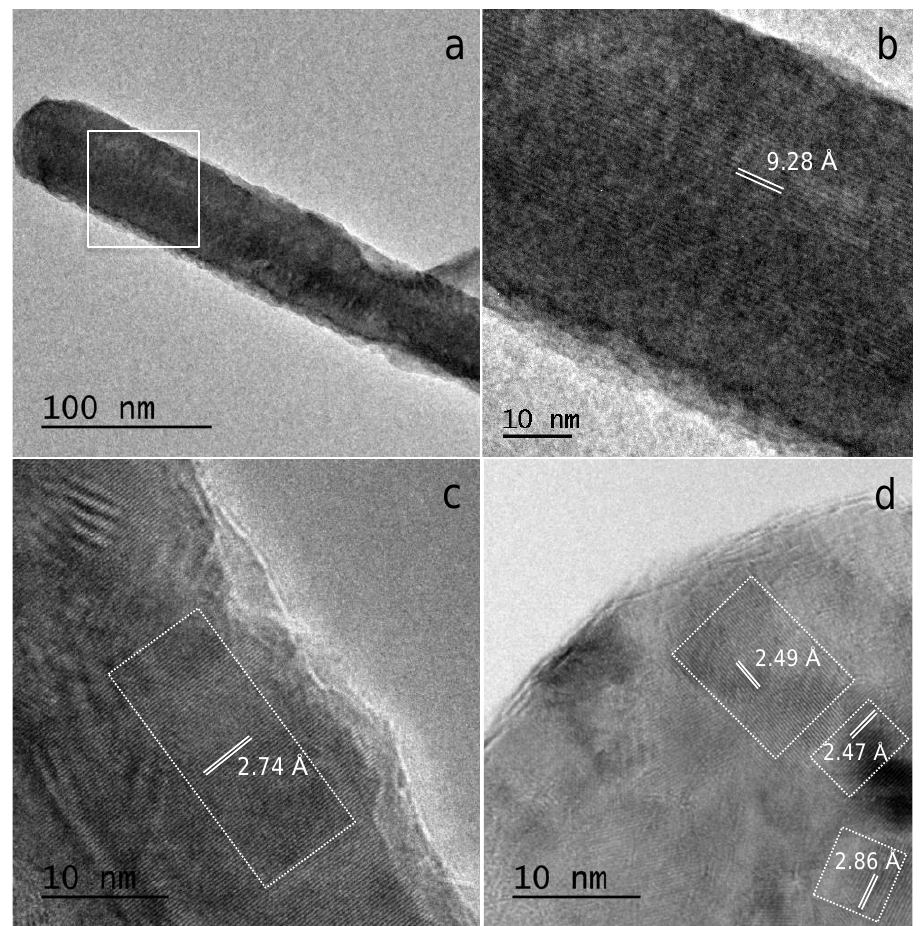
Figure 3. HRTEM images of un-hydrated MTA Repair HP material and d hkl measurements: ( a ) characteristic elongated nanoparticle, and ( b ) magnification of the ( a ) square inset; ( c ) elongated nanoparticle edge and measured nanodomain; ( d ) irregular polycrystalline particle showing different nanodomains.